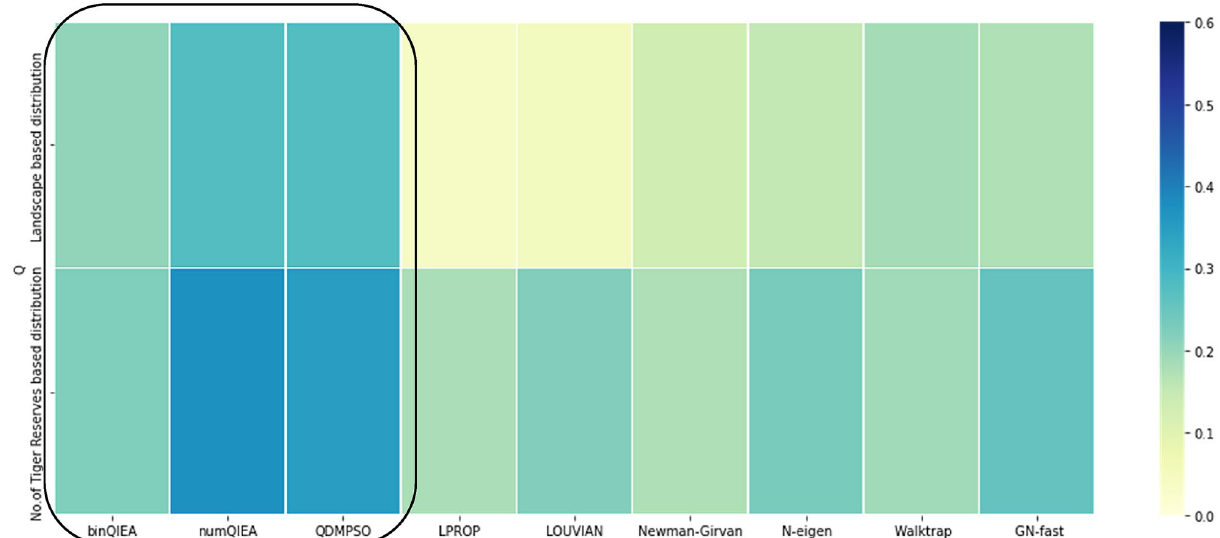
Figure 5. Modularity comparison of QIML versus standard CD techniques for two novel